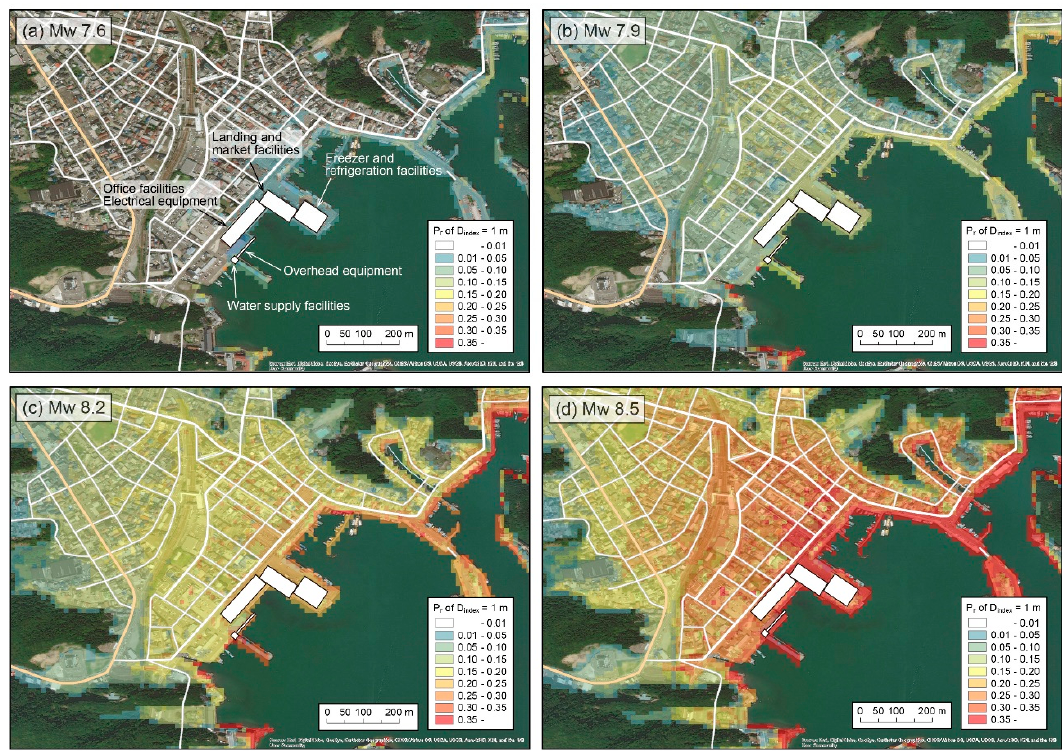
Figure 7. Probability distribution of tsunami inundation depth exceeding 1 m at Nachi-Katsu’ura Fishery Port. ( a ) Tsunami scenario for an Mw 7.6 cases, ( b ) Mw 7.9 cases, ( c ) Mw 8.2 cases, ( d ) Mw 8.5 cases.